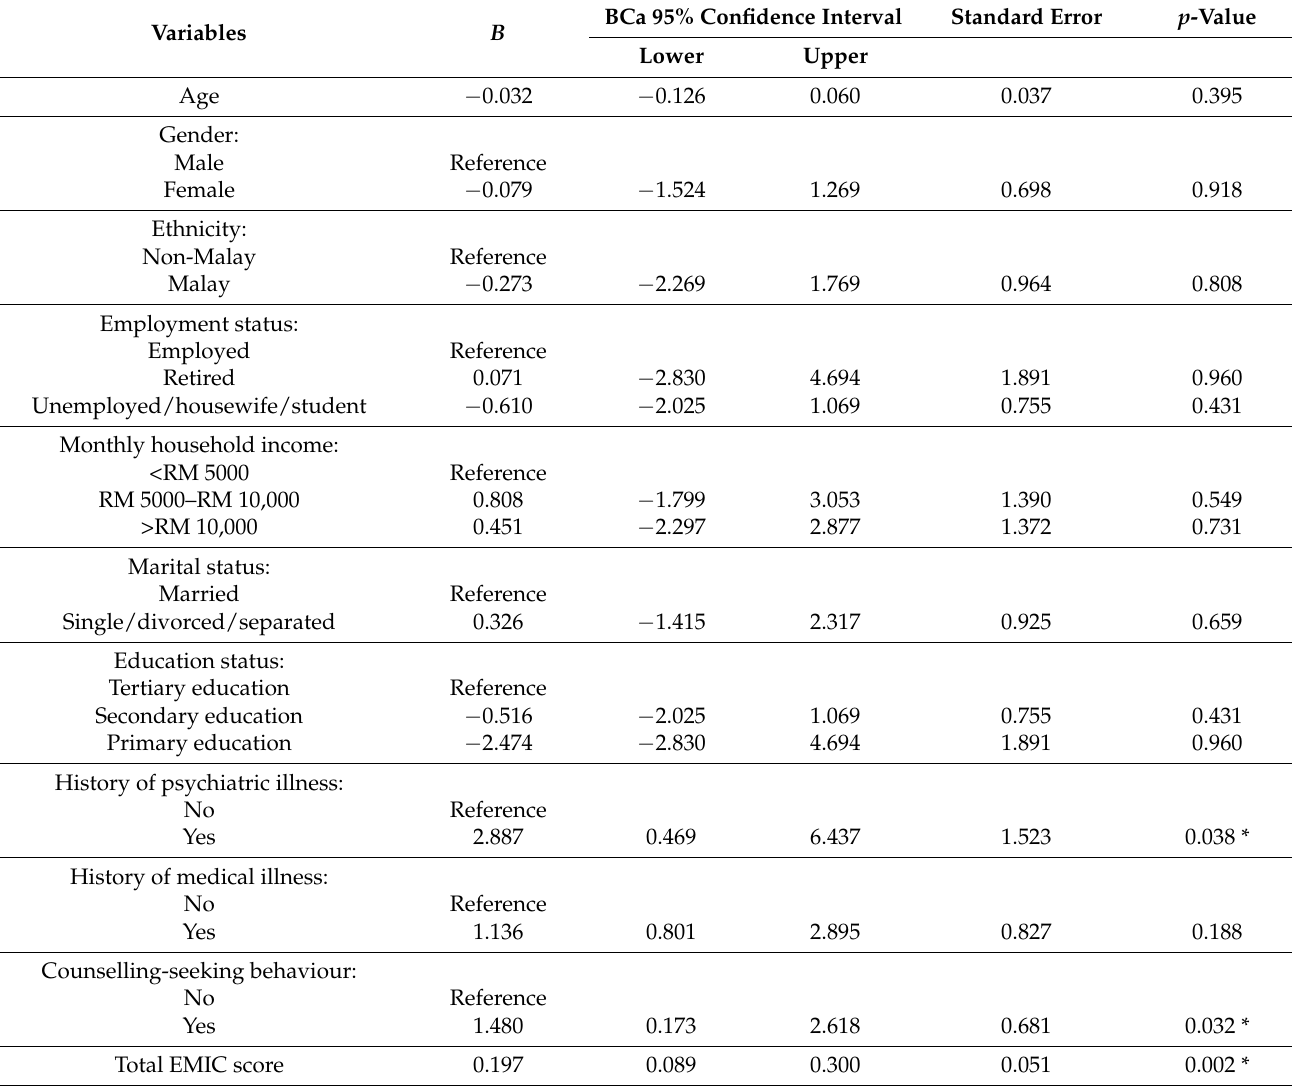
Table 3. Multivariate general regression model with bootstrapping with 2000 replications for socio- demographic and clinical characteristics, perceived stigma, and severity of psychological distress among COVID-19 patients after six months of being discharged from the